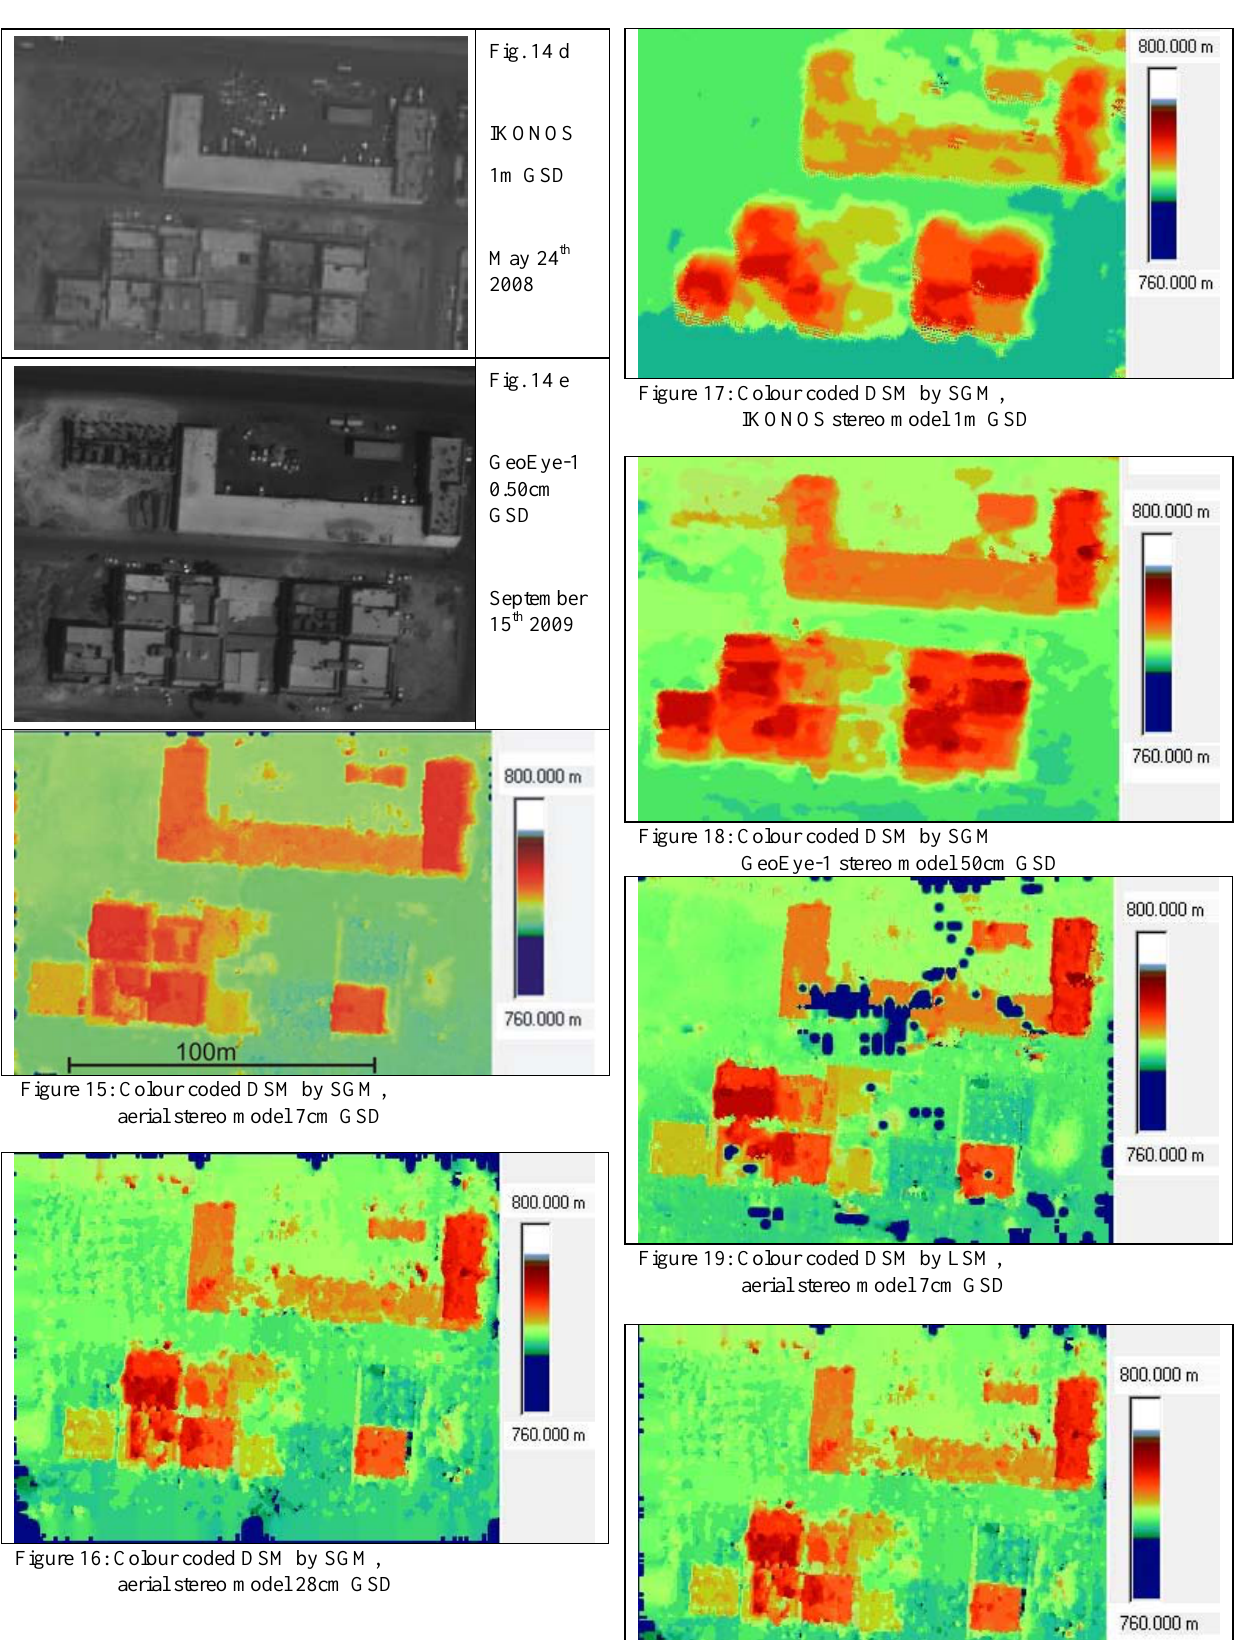
Figure 20: Colour coded DSM by LSM, aerial 28cm